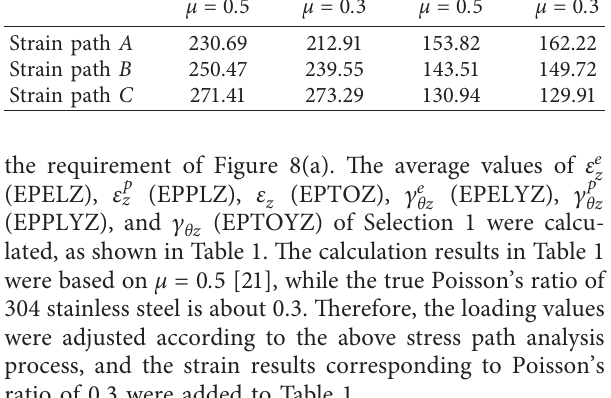
Table 2: FEA results of strain paths A, B, and C.